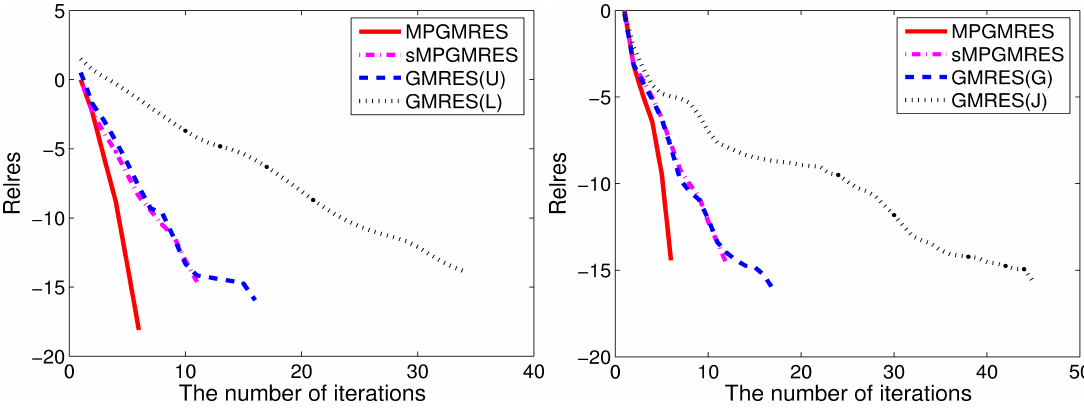
Fig. 3. Convergent histories of the MPGMRES, sMPGMRES, GMRES( L ) and GMRES( U ) for Example 4.2 when l = 8192 (left).